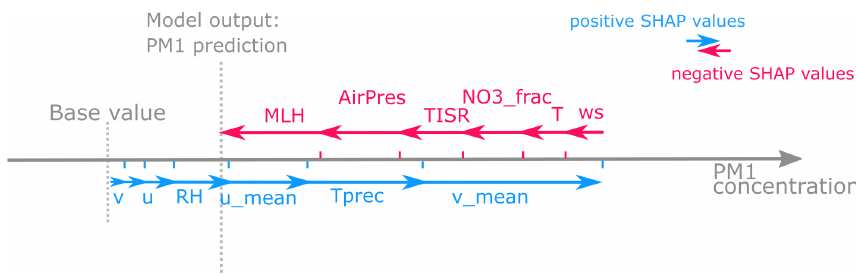
Figure 2. Conceptual figure illustrating the interaction of SHAP values and model output. Starting with a base value, which is the mean pre- diction if all data points are considered, positive SHAP values (blue) increase the final prediction of total and speciated PM 1 concentrations, while negative SHAP values (red) decrease the prediction. The sum of all SHAP values for each input feature yields the final prediction. Depending on whether positive or negative SHAP values dominate, the prediction is higher or lower than the base value (Lundberg et al., 2018). Adapted from https://github.com/slundberg/shap (last access: 15 March 2021).